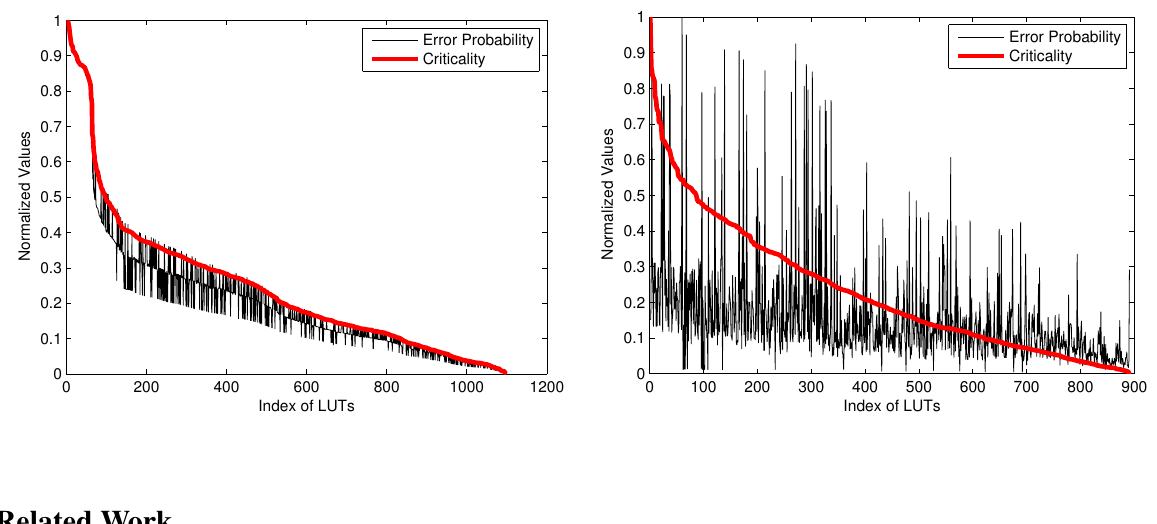
Figure 11. Profile comparison between LUT criticality and LUT error probability values. (a) Results of circuit FLIP _ RISKS . (b) Results of circuit Ex1010